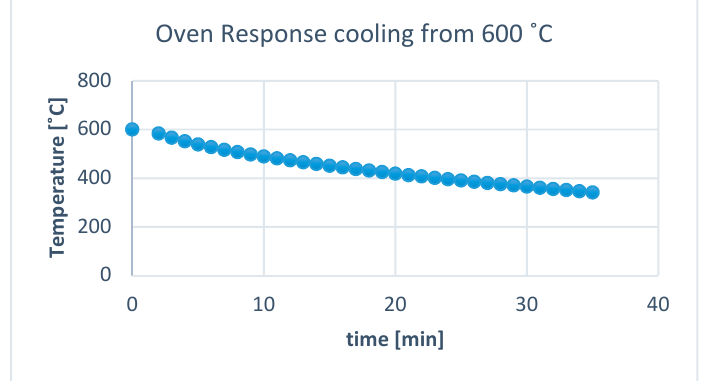
Figure 2. Cooling curve of the Carbolite electrical oven (600 °C–300 °C) with 100 g silica gel sample